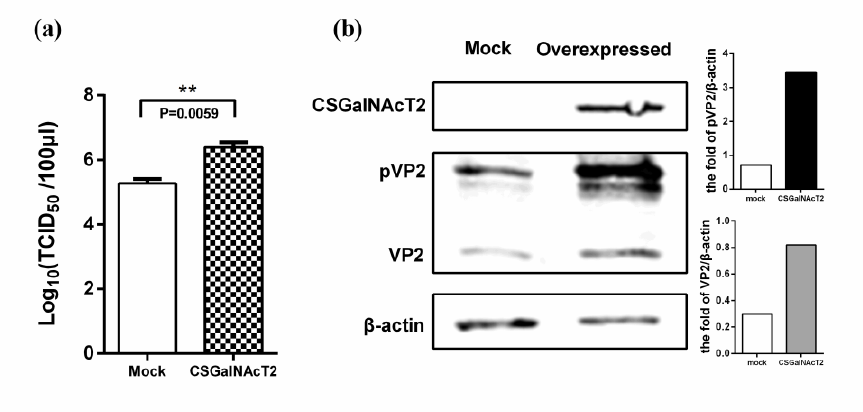
Figure 4. Overexpression of CSGalNAcT2 promotes IBDV replication. To determine the effect of up-regulation of CSGalNAcT2, overexpression assays were performed. DF1 cells were transfected with 4 μg pCSGalNAcT2 in 6-well plates. Then, the cells were infected with IBDV Gt strain at 36 h post-transfection. At 48 h post-infection, the cell supernatants were collected for determining the viral titre and the cell monolayers were lysed for detecting the VP2 expression levels. ( a ) The viral titre in the supernatant was determined by TCID 50 . The titre of the overexpression group was markedly higher than that in the mock. ( b ) The intracellular viral load was reflected by the VP2 or pVP2 expression levels, as determined using Western blotting. After normalized to beta-actin, the VP2 or pVP2 content in the overexpression group presented three to five times higher than that in the mock group. Values represent the mean ± SEM of three independent experiments. ** , p < 0.01, significantly